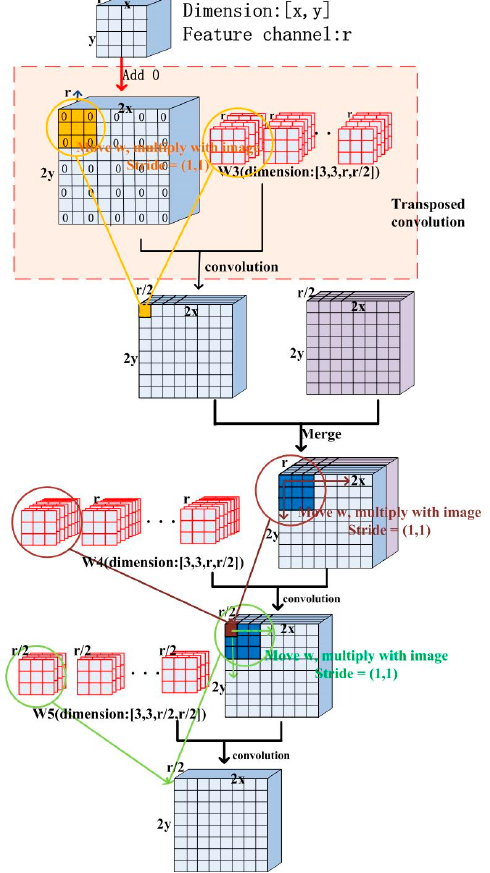
Figure 2. Process of up-sampling.